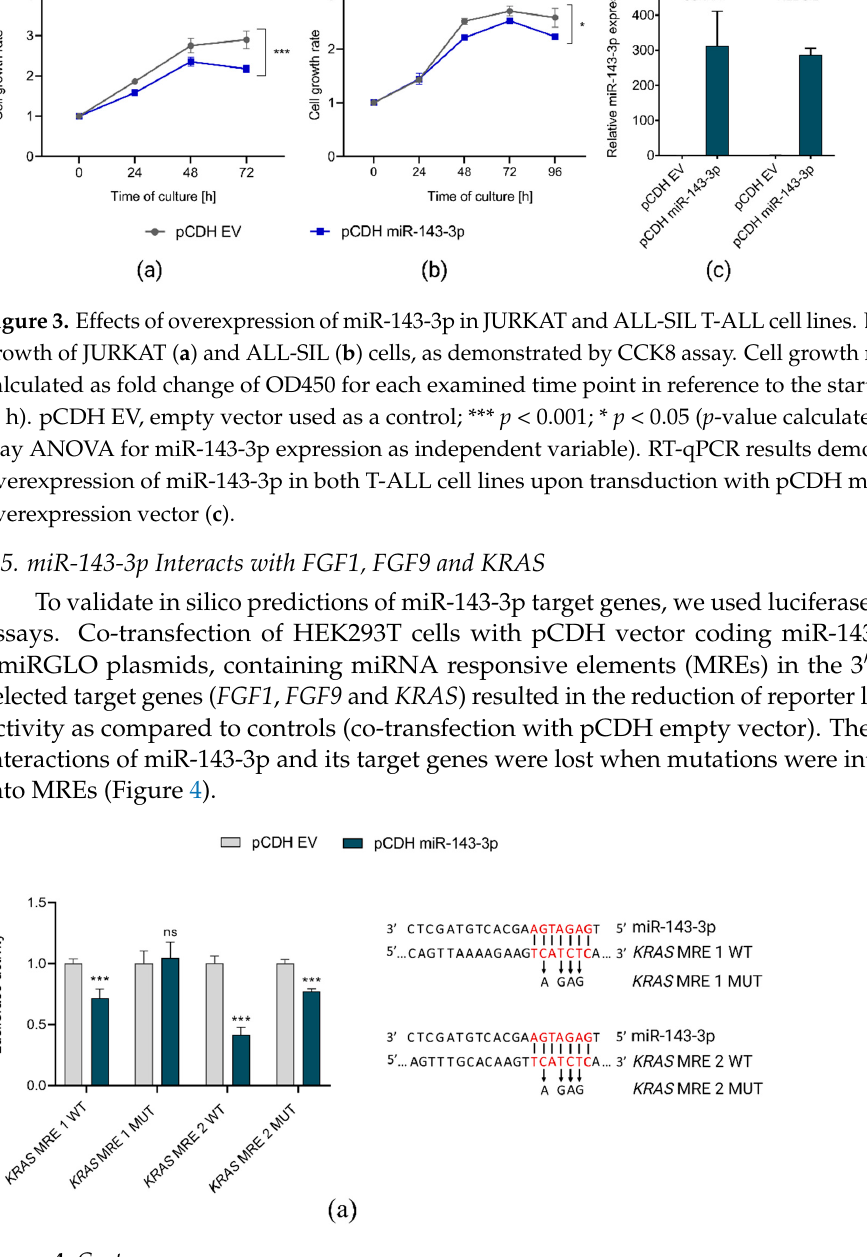
Figure 4. In vitro validation of direct interactions of miR-143-3p with FGF1 , FGF9 and KRAS . pCDH EV, pCDH empty vector; pCDH miR-143-3p, pCDH vector containing miR-143-3p coding sequence MRE, miRNA responsive element in 3 ′ UTR of target gene; WT, wild-type sequence; MUT, sequence with mutations introduced within MRE; *** p < 0.001; ** p < 0 .01; * p < 0.05; ns, not significant. The graphs present the decrease in relative luciferase activity in the presence of miR-143-3p in reference to control (empty vector). For each graph, the predicted interaction sites of miR-143-3p with MREs are shown, with indication of nucleotides mutated in the rescue experiment. ( a ) Interactions be- tween miR-143-3p and two MREs in KRAS gene. ( b ) Interaction between miR-143-3p and MREs in FGF1 gene. ( c ) Interaction between miR-143-3p and MREs in FGF9 gene. 3. Discussion The major finding of the study is the similarity of miRNA transcriptome in pediatric and AYA patients. An additional but potentially important observation is the downregu- lation of miR-143-3p in T-ALL patients and its putative involvement in leukemia biology as shown by our in silico predictions and basic functional experiments. Among predicted targets of this miRNA, there are several oncogenes significantly overrepresented in sig- naling pathways of potential importance for T-ALL cells (Figure 2b). miR-143-3p and its target genes ( FGF1 , FGF9 , KRAS ) clearly stand out from this overrepresentation analysis (Table S4). Since these genes are implicated in cell proliferation, apoptosis, and stress re- sponses, we hypothesized that insufficient negative regulation over these oncogenes by downregulated miR-143-3p might serve as an oncogenic mechanism in this leukemia. We demonstrated that overexpression of this miRNA in two T-ALL cell lines resulted in the